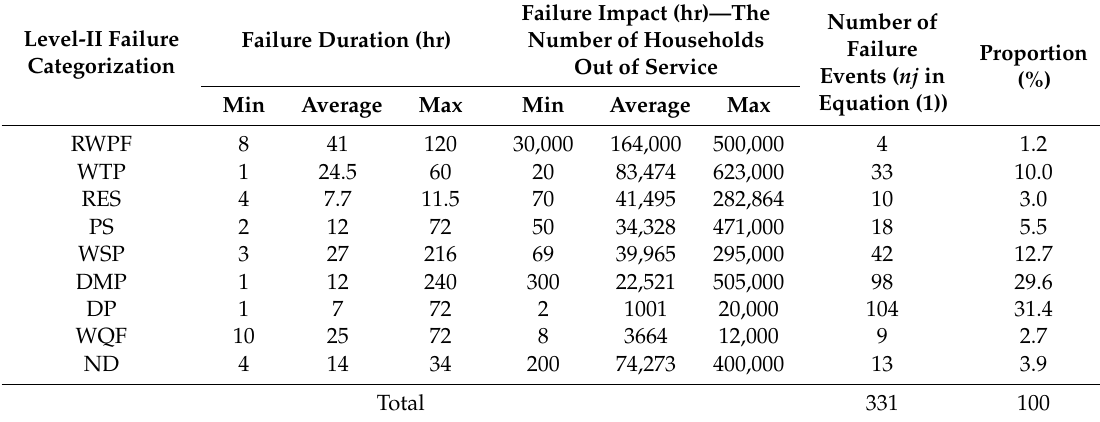
Table 2. Statistics of the historical water supply and distribution system (WSDS) component failures considered in this study.